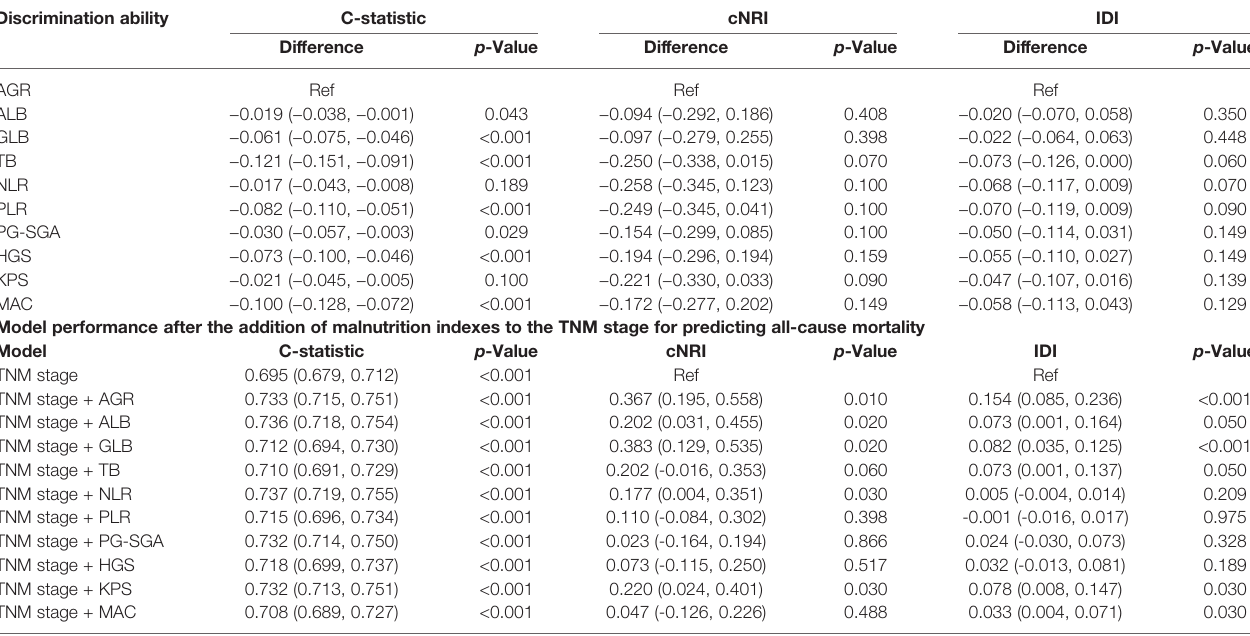
TABLE 4 | Comparative analysis of the discrimination of each malnutrition score for all-cause mortality in training cohort. Discrimination ability